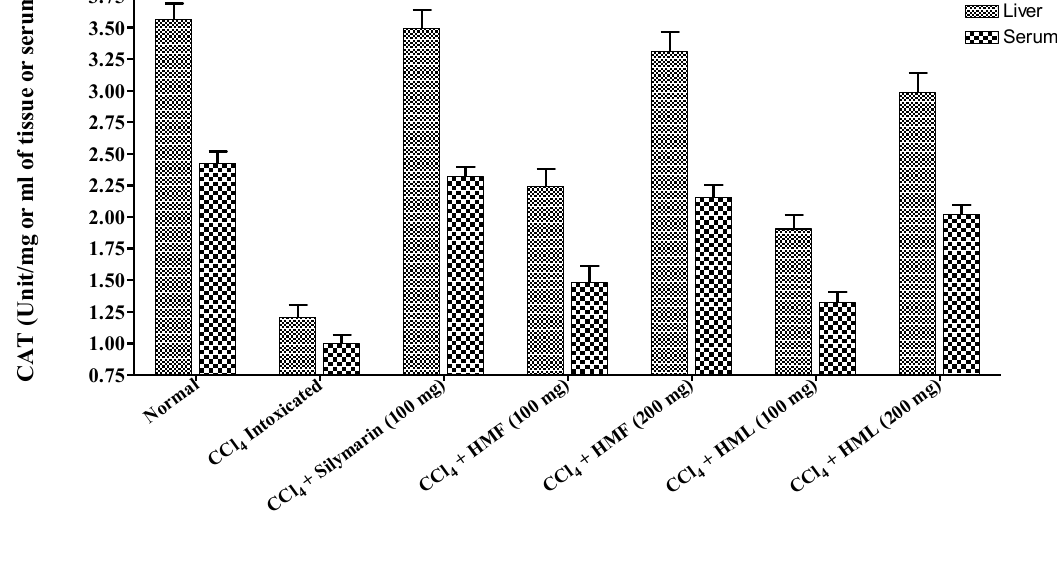
Figure 1. The effect of HMF and HML on CAT enzyme levels in liver and serum.